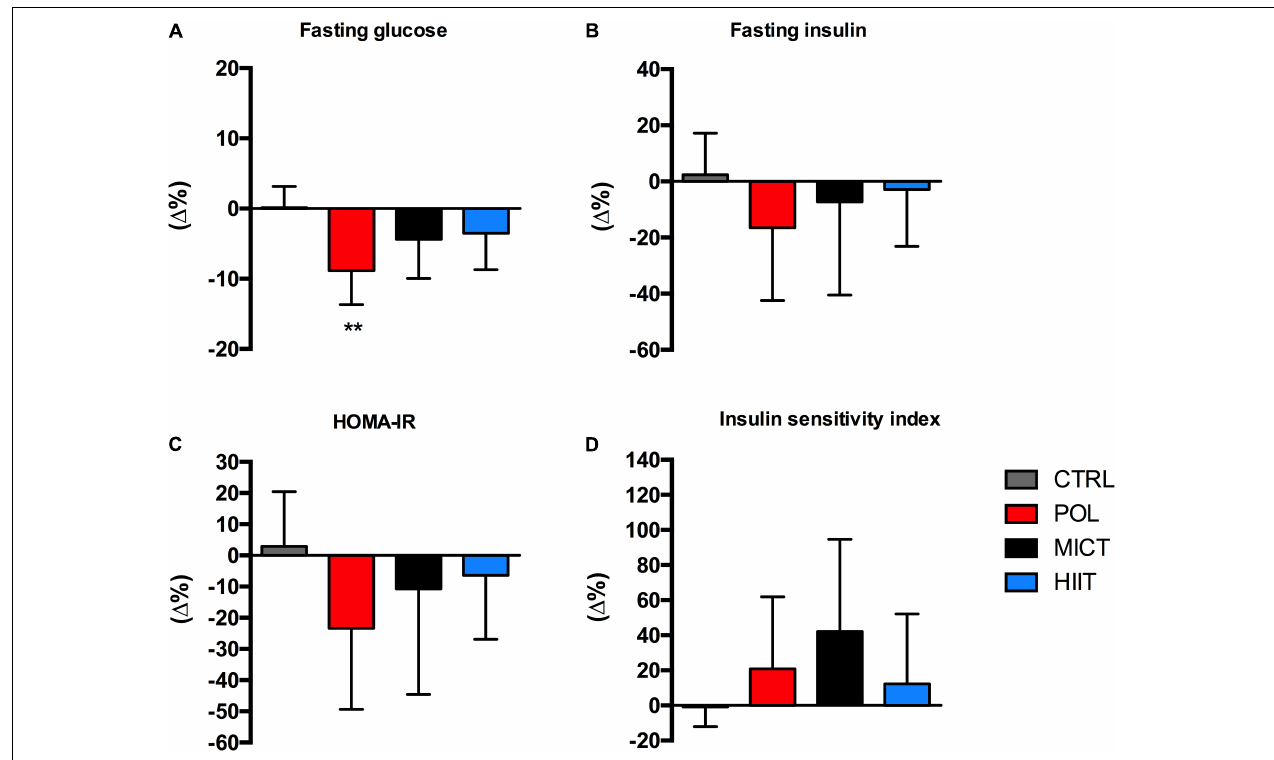
FIGURE 4 | Effects of training intervention on glycemic control. (A) Fasting plasma glucose, (B) fasting plasma insulin, (C) HOMA-IR, and (D) insulin sensitivity index before and after 12-weeks of control (CTRL), polarized volume training (POL), moderate-intensity endurance training (MICT), and high-intensity interval training (HIIT). Data are shown as mean ± SD of relative fold changes ( (cid:49) %). ∗∗ Denote differences between pre and post-training values ( p < 0.01). The comparison was performed with Mixed Factorial ANOVAs with Bonferroni’s post hoc test for multiple comparisons. HOMA-IR, homeostasis model for assessment of insulin